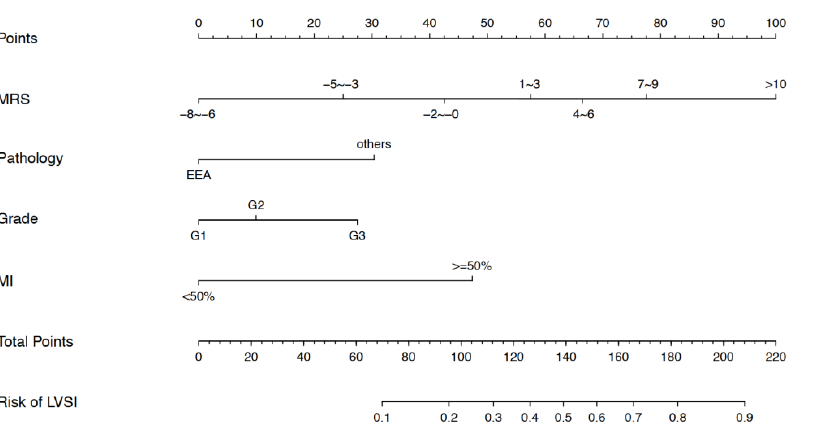
Figure 2. AUC of clinicopathologic model and MRS-based nomogram for prediction of LVSI in EC in ( A ) training cohort and ( B ) validation cohort.